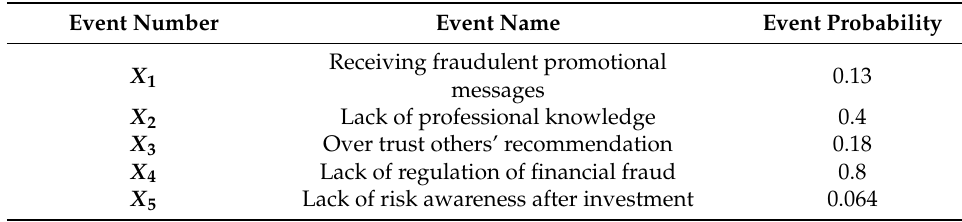
Table A6. Event name and base probability.